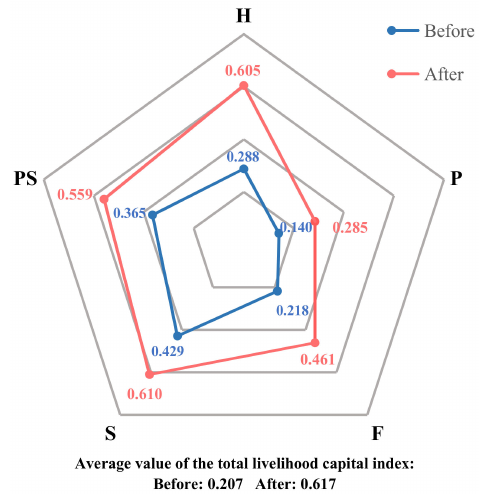
Figure 3. Pentagon of the five forms of livelihood capital. H: human capital, P: physical capital, F: financial capital, S: social capital, PS: psychological